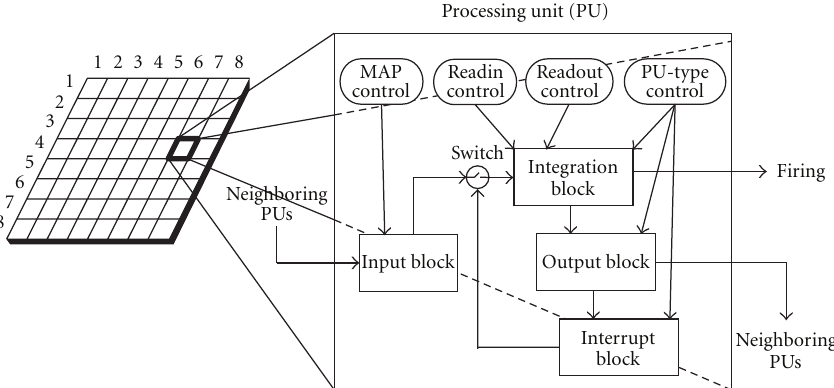
Figure 2: Conceptual architecture of a PU. The input block is illustrated in Figure 3, the interrupt block in Figure 4(a), the output block in Figure 4(b), and the integration block in Figure 6.